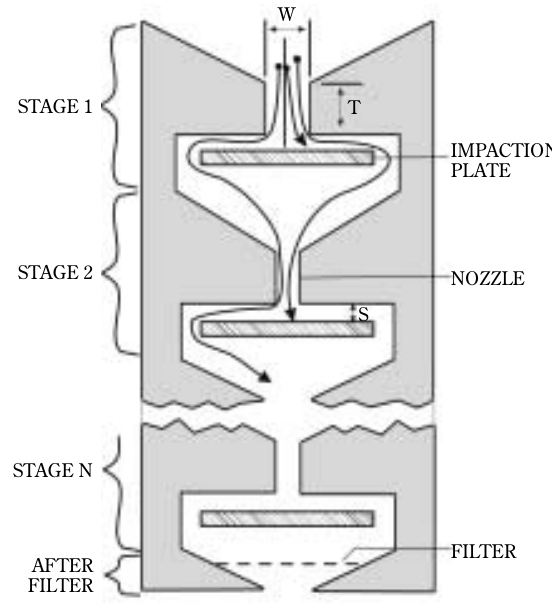
Fig. 4 Schematic of a multi-stage impactor, showing the separa- tion of progressively finer particles as the aerosol passes through successive stages to the after filter